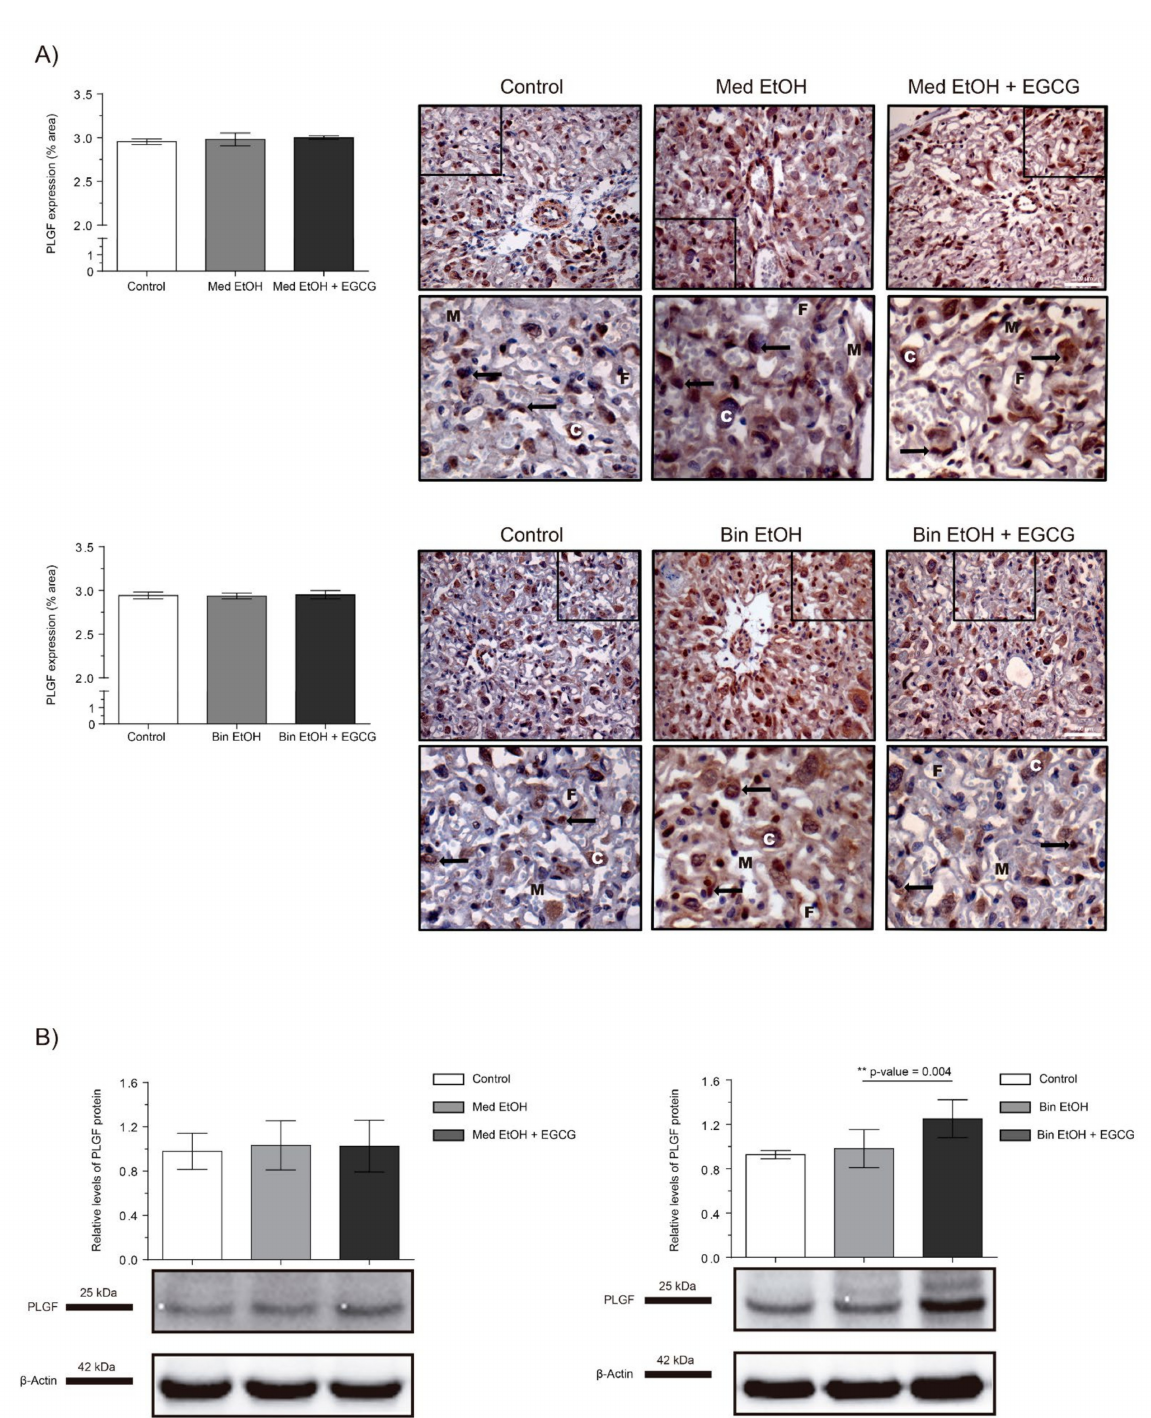
Figure 3. Representative placental growth factor (PLGF) immunostaining in placenta sections ( A ) and Western blot PLGF protein analysis in placental lysed samples ( B ) for PAE and EGCG treatment for binge and Mediterranean patterns. ( A ) Boxed sections in placental growth factor protein immunostaining represent an enlarged image of the labyrinth zone. PLGF protein quantification for two different fields (40 × ) per section. ( B ) Representative Western blot of PLGF protein expression observed in all samples analyzed under the various experimental conditions. Protein levels were normalized using α -tubulin as load control. Arbitrary units express “fold change”. At least five samples from different litters were used from each group. For intergroup comparisons, the Kruskal–Wallis test (Dunn’s test for multiple comparisons) was used. Asterisks denote the level of significance: ** p -value < 0.01. M: maternal blood; F: fetal blood; C: cytotrophoblast; arrows: PLGF positive